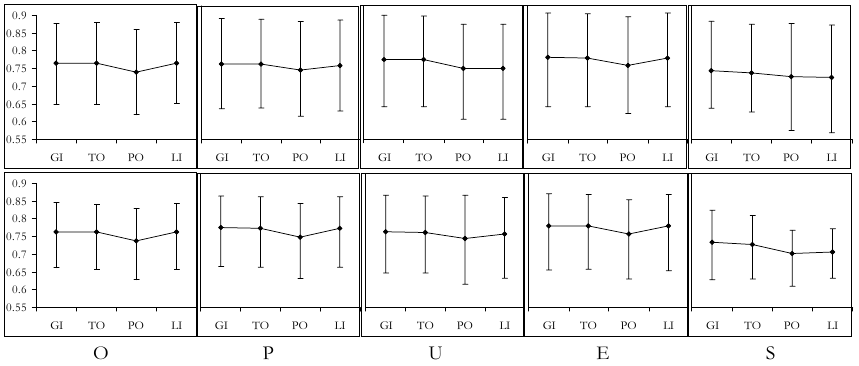
O P U Figure 3 – MGM mean correlations µ 11 (row 1) and µ 22 (row 2), with the associated ranges, of the m i variables with the subscale to which they were a priori assigned to, obtained by the four scoring methods GI (Gifi), TO (Torgerson), PO (Portoso) and LI (linear assignment) for each discretization type ( O =optimal, P =pseudo-optimal, U =U-shape, E =equal, S =skew), with reference to the data set with λ =[0.45, 0.45].